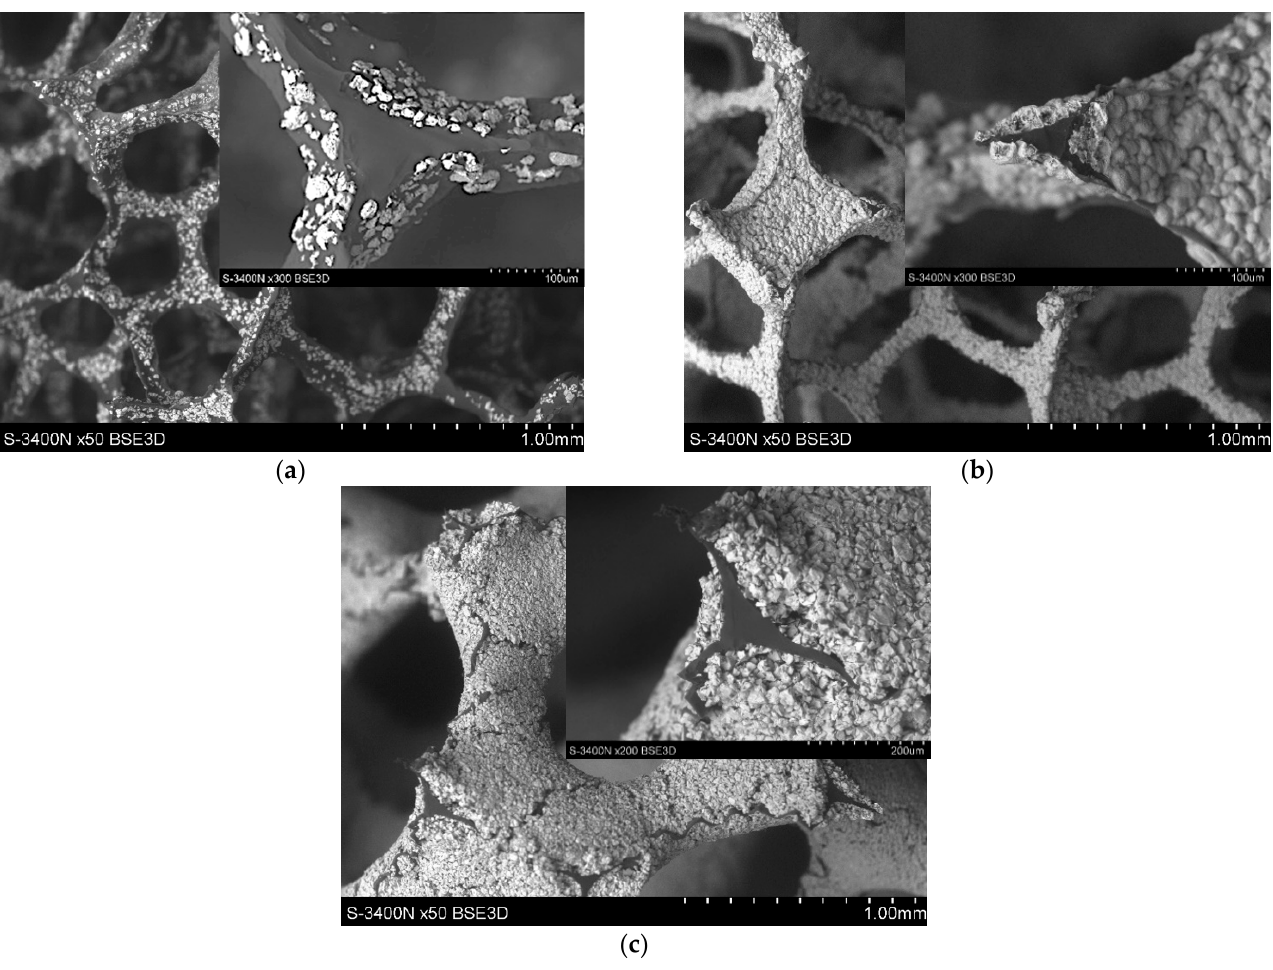
Figure 7. The microstructure of the obtained reinforcement layers varied according to Ti particle suspension: ( a ) 10 vol.%; ( b ) 25 vol.%; ( c ) 40 vol.% in PF resin suspension. In insets, the cross-sections of foam are presented (SEM).